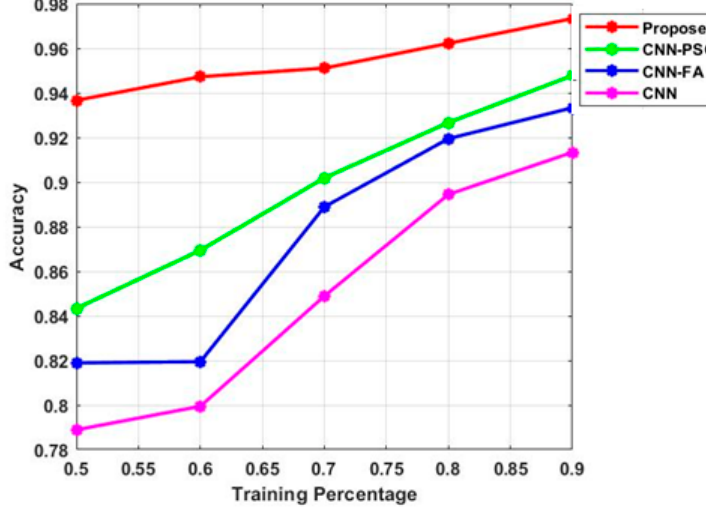
Figure 8. Accuracy. Figure 8. Accuracy.